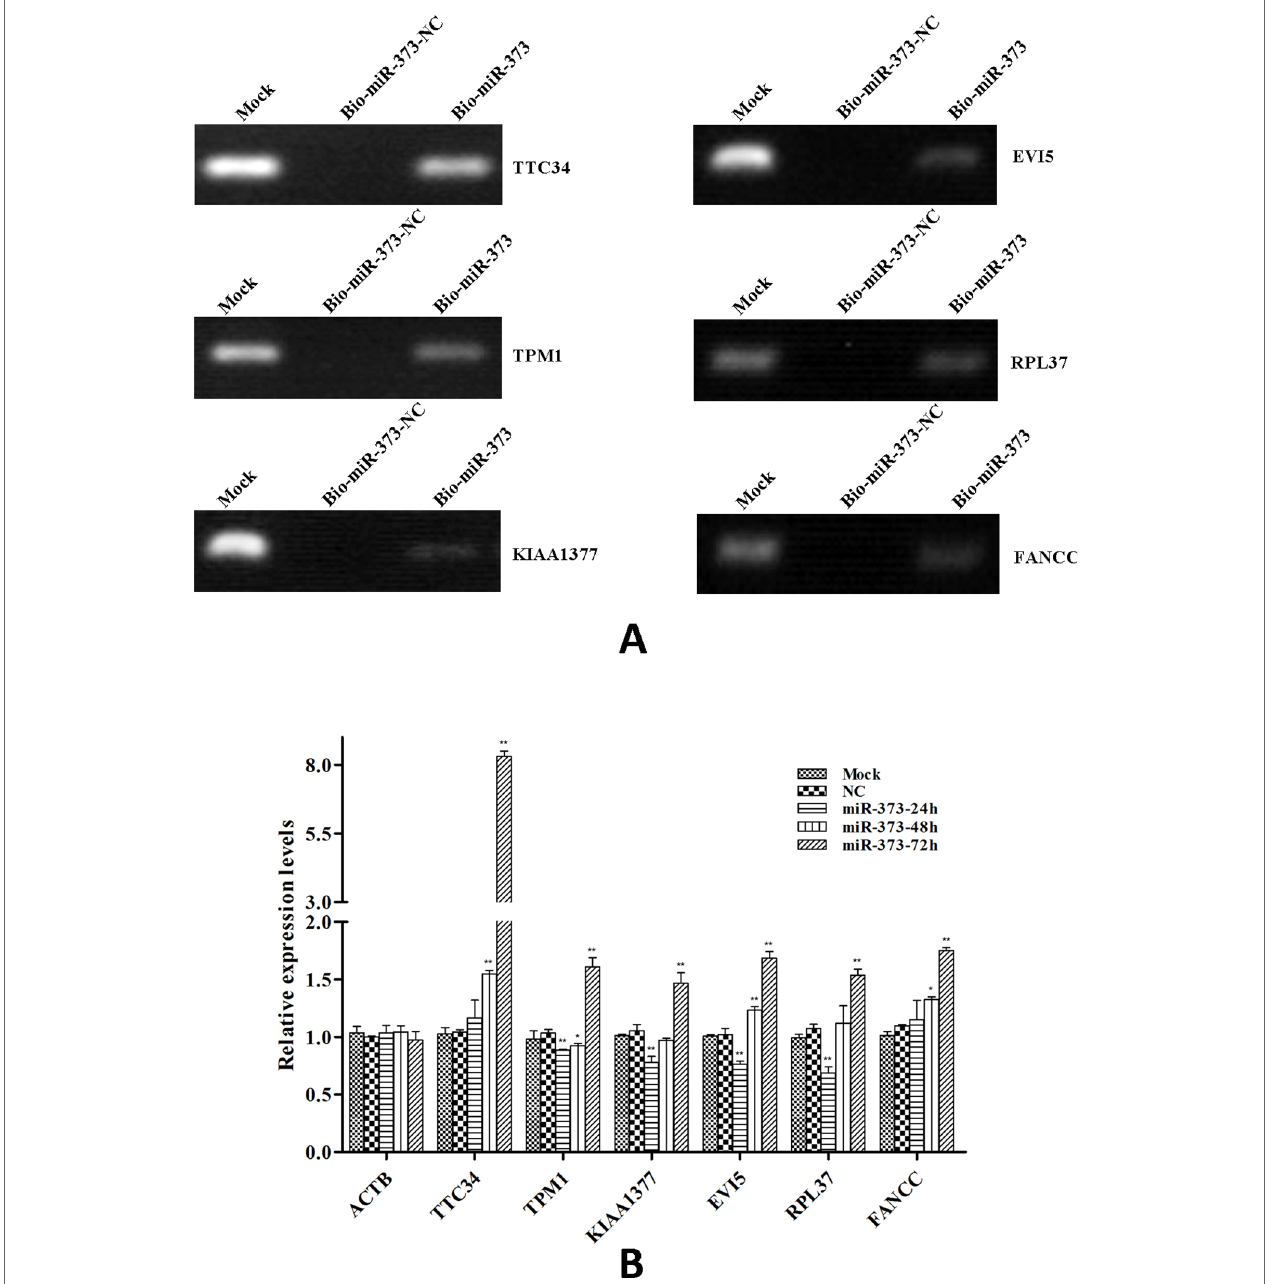
FIGURE 7 | The identified genes via next-generation sequencing can be regulated by miR-373. (A) Bio-miR-373 or bio-NC-miRNA was transfected into MCF-7 cells for 24 h. Then cells were harvested, and the DNA fragments were enriched via DNA–miRNA pull-down assay. The enrichments of TTC34, EVI5, TPM1, RPL37, KIAA1377, and FANCC promoters were measured by semi-quantitative PCR. (B) MCF-7 cells were transfected with miR-373 or NC-miRNA. Cells were harvested after 24, 48, or 72 h post-transfection. Real-time PCR was used to measure the mRNA level of identified genes. The expression of β -actin was used as the internal reference. n = 3, * P < 0.05, ** P < 0.01 compared with the sample transfected with NC